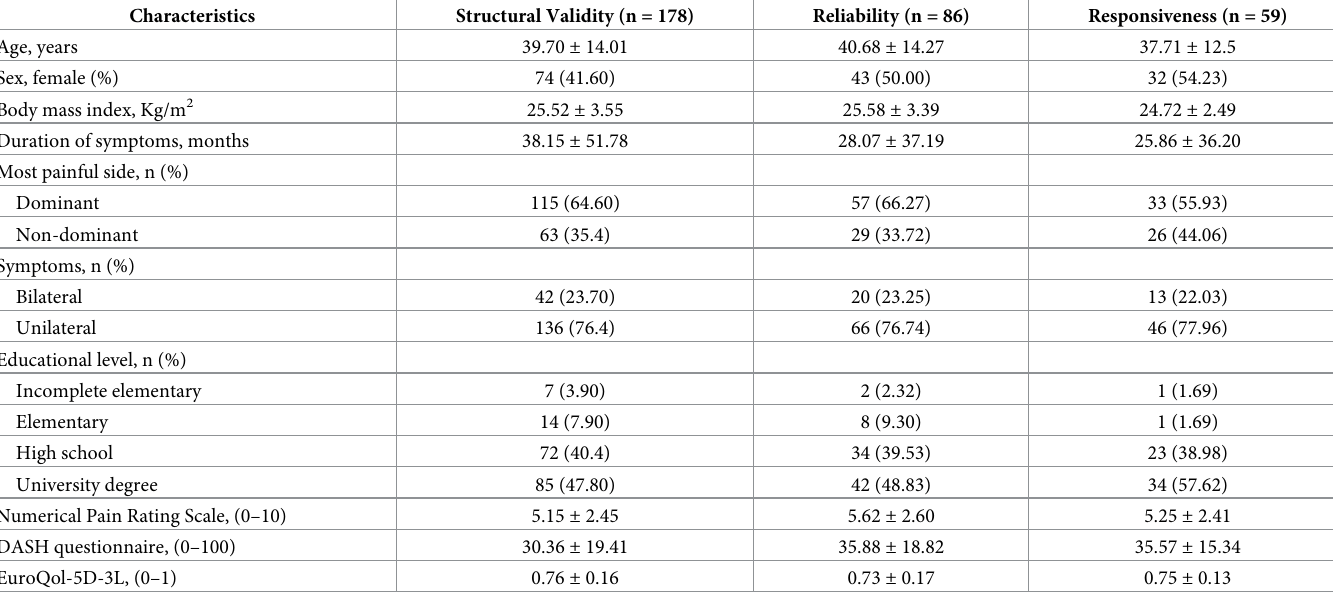
Table 1. Characteristics of the individuals according to the analyzed measurement property.